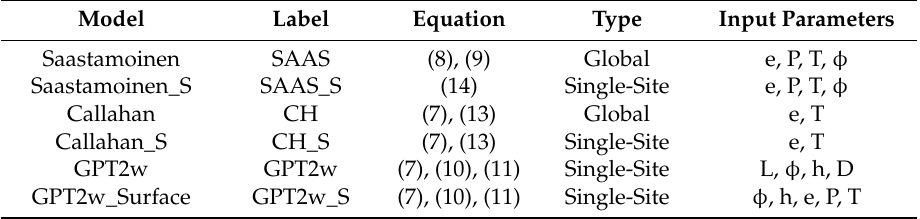
Table 1. Abbreviation, equations, types, and input parameters for tropospheric